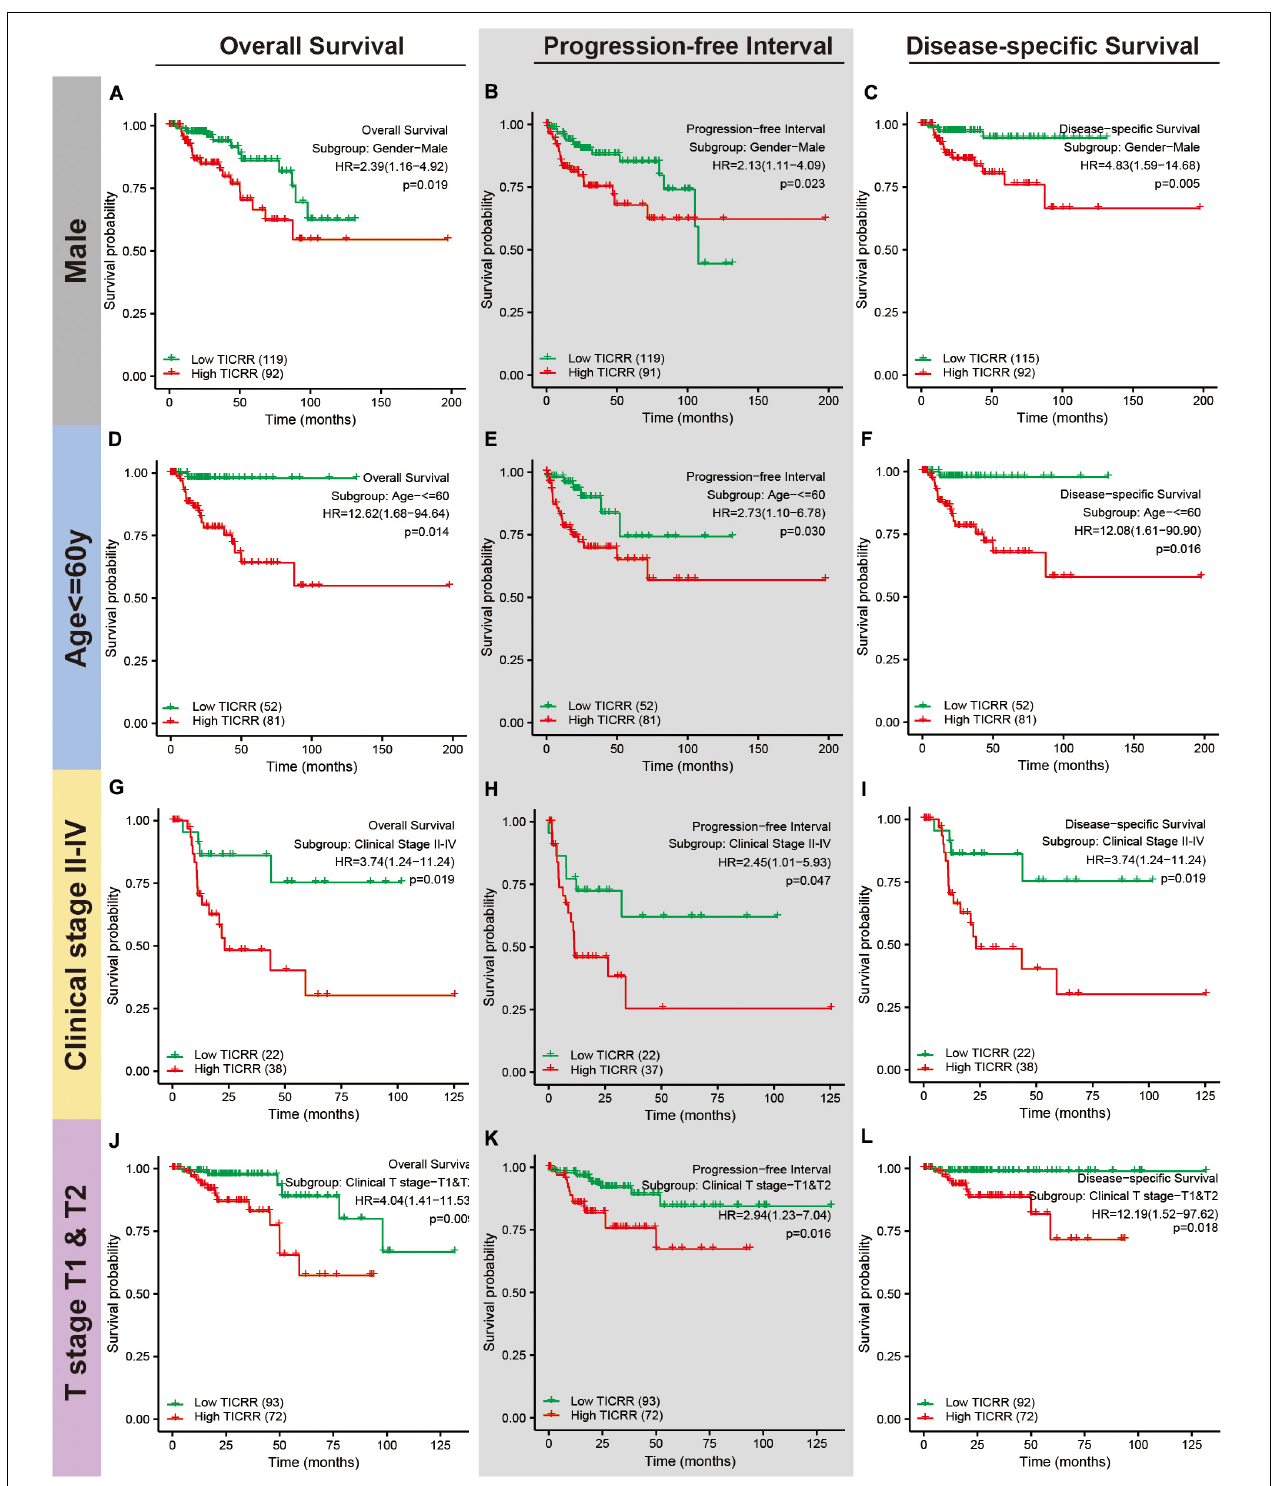
FIGURE 8 | Distinct clinical outcomes based on TICRR expression in papillary renal cell carcinoma (PRCC) patient subgroups. Kaplan–Meier analysis showing the comparison of overall survival (A,D,G,J) , progression-free interval (B,E,H,K) , and disease-specific survival (C,F,I,L) between high- and low- TICRR expression groups in several PRCC patient subgroups, including male sex (A–C) , age below 60 years (D–F) , clinical stage II–IV (G–I) , and T stages T1–T2 (J–L) .